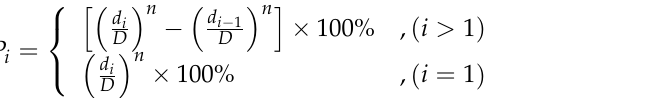
Figure 4. Schematic design for testing water–gas two-phase seepage parameters in fractured coal bodies. During the test, the axial and seepage pressures were taken as follows: the test was divided into five groups of ZS-01, ZS-02, ZS-03, ZS-04, ZS-05 according to the axial pressure gradient, and the axial load was applied at a constant loading rate of 0.05 kN/s for five axial pressures (5 kN, 10 kN, 15 kN, 20 kN, and 25 kN), respectively. 3.2.2. Experimental Equipment The data acquisition device includes a paperless recorder, computer, and various sensors. The main sensors include flow transmitters and pressure transmitters, among which water and gas flow transmitters are divided into the corresponding turbine-type and vortex-type transmitters. The vortex-type flow transmitter measurement range is 1 to 20 m 3 /h, the turbine-type flow transmitter measurement range is 0 to 1 m 3 /h, using a flow transmitter pressure resistance of 6.3 MPa, and the pressure transmitter measurement